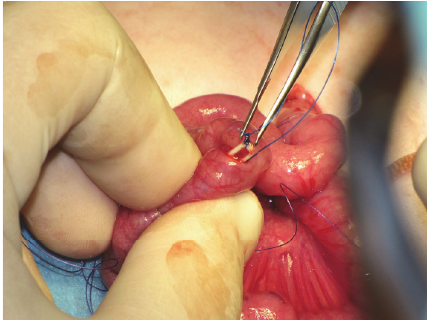
Figure 4: The guide thread was grasped and brought out through the abdominal wall using a needle.